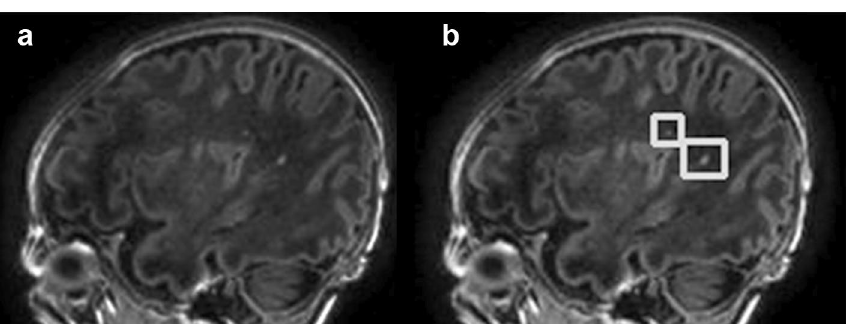
Figure 2. Automatic detection of punctate white matter lesions (PWMLs) in an infant: two PWMLs in a sagittal T1-weighted image ( a ) are correctly detected ( b ,